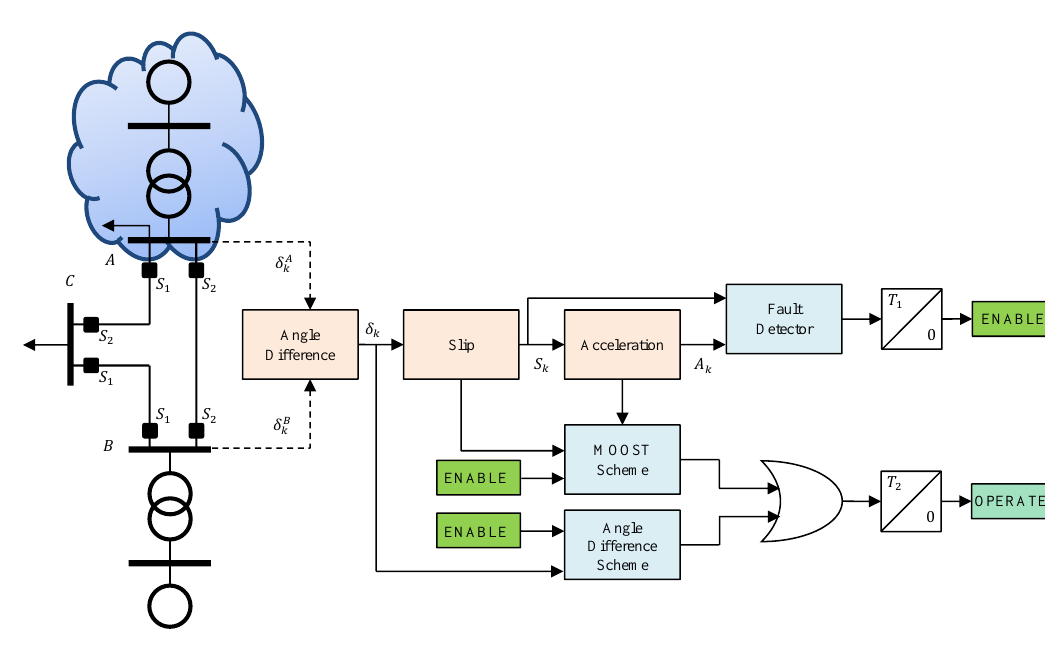
Figure 3. Active splitting scheme (ASS) for longitudinal power system (LPS) based on a wide-area monitoring, protection and control (WAMPC).